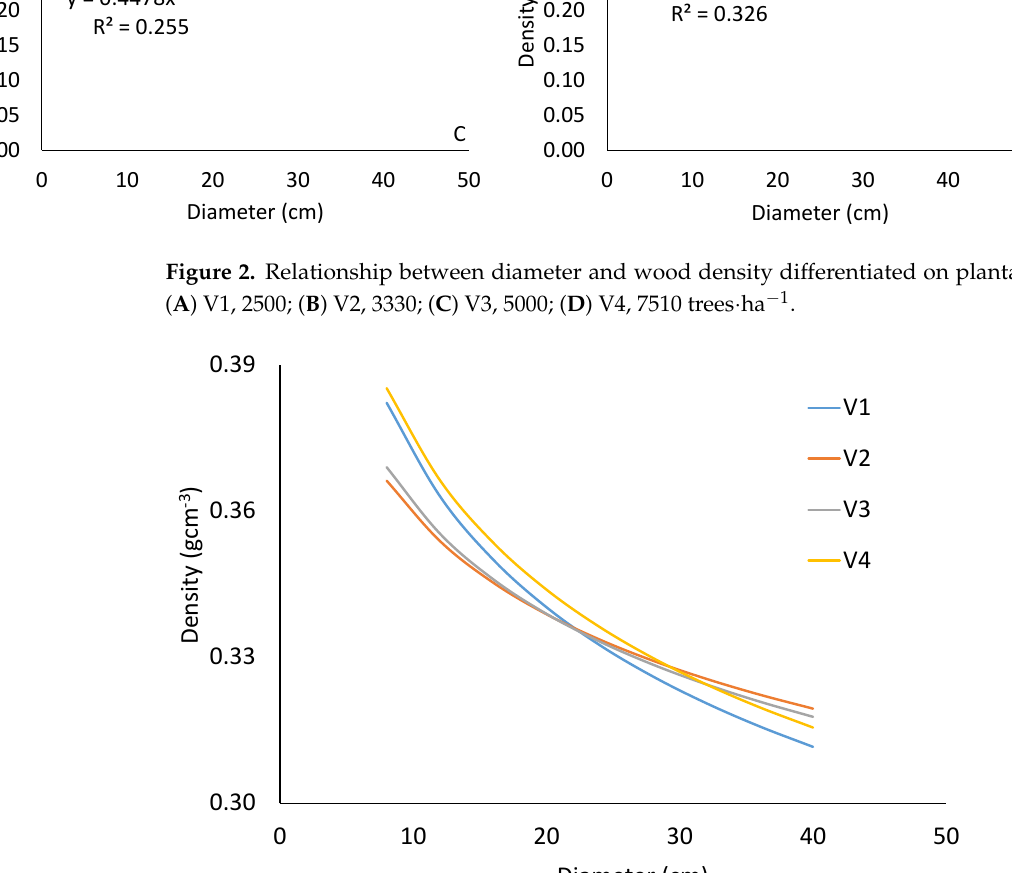
Figure 3. Average density curves in relation with diameter and plantation variant.